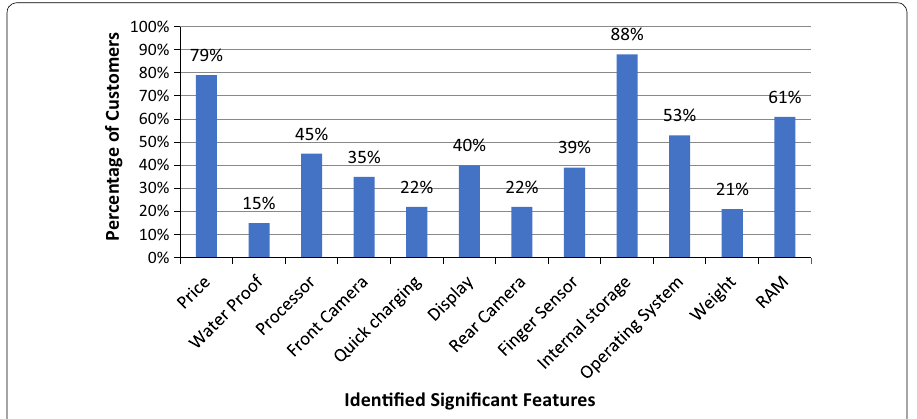
Fig. 2 Identified Significant Features from Customer reviews and